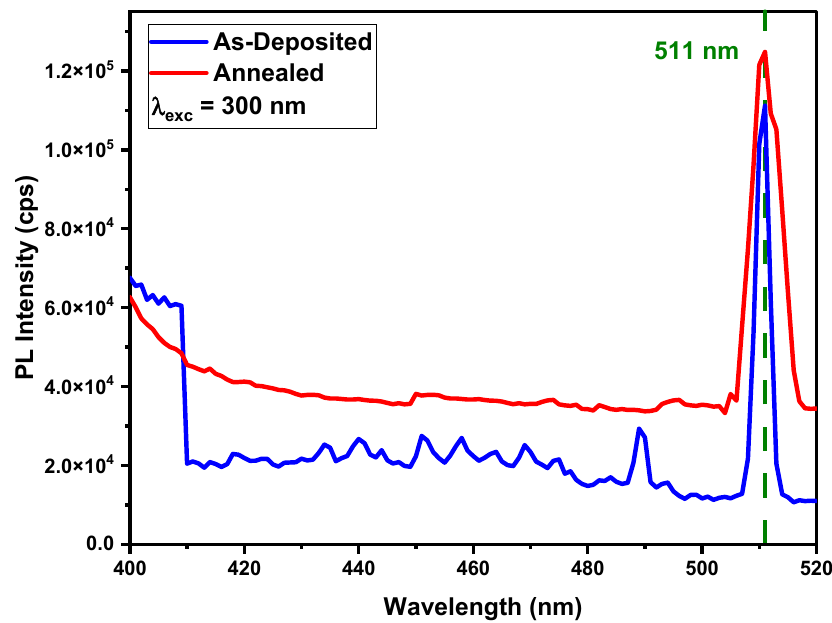
Figure 7. PL emission spectrum of as-deposited and annealed Ni-doped AlN thin films at an exci- tation of 300 nm. Hence, photoluminescence in AlN thin film was responsible for two mechanisms: (a) intra-center luminescence and (b) recombination ruminescence, which were observed by